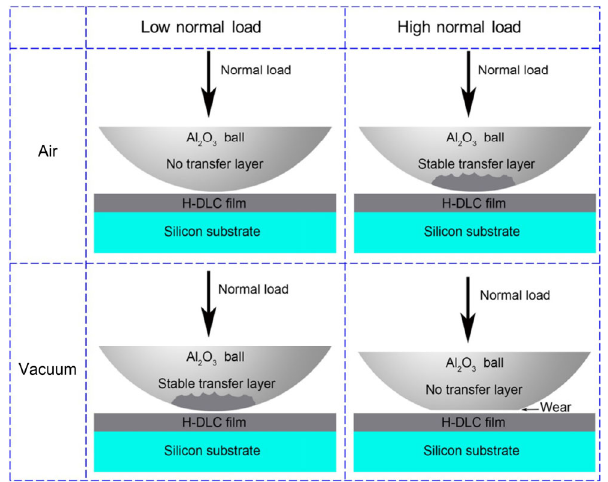
Fig. 3 Lubricating performance of an H–DLC film in air and vacuum. In air, the transfer layer can only come into being under a high normal load, in which case friction can be reduced. However in vacuum, the transfer layer can only be maintained under low normal load that generates superlubricity, which degrades under a high normal load [34]. © authors,